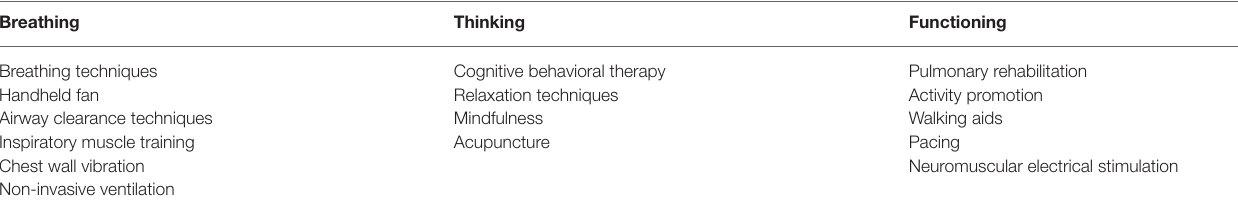
TABLE 1 | The categorization of symptom management approaches according to breathing, thinking, functioning domain (98).